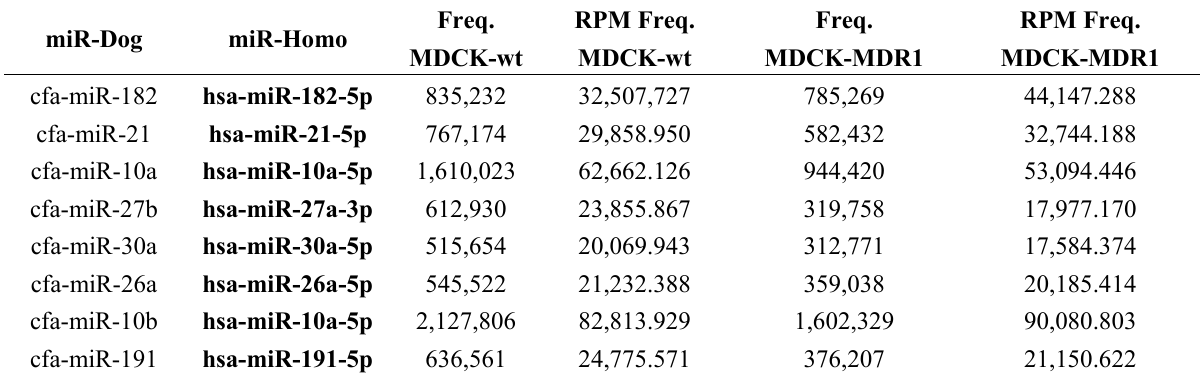
Table 2. Frequence of miRNAs higly expressed in MDCK-wt and MDCK-MDR1.